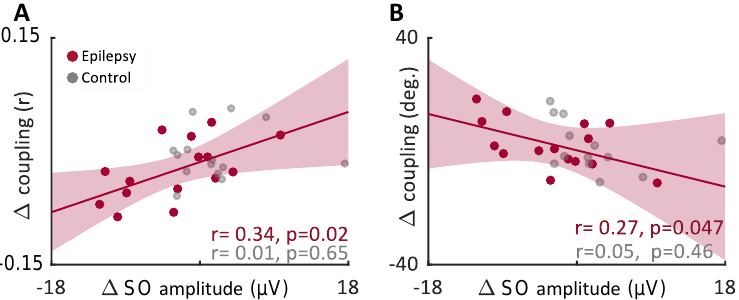
Figure 6. Medication-related changes in coupling and slow wave amplitude are correlated: ( A ) Linear correlation of the change in coupling strength and the change in Slow Wave (SO) amplitude after ASM polytherapy (red), or between nights in the Control group (grey). Each point represents the change between nights for an individual. A reduction in slow wave amplitude is correlated with a significant reduction in coupling strength (F-statistic of fit p = 0.024, R 2 = 0.34). The Control group had no such correlation (F-statistic p = 0.63, R 2 = 0.019). ( B ) The phase of coupling was similarly correlated, such that a reduction in slow wave amplitude was correlated with an increase in phase, shifting the phase closer or even past the slow wave peak of 0 ◦ (more depolarized) (F-statistic of fit: p = 0.047, R 2 = 0.27). The Control group showed no such correlation across day (F-statistic of fit p = 0.46, R 2 = 0.04).